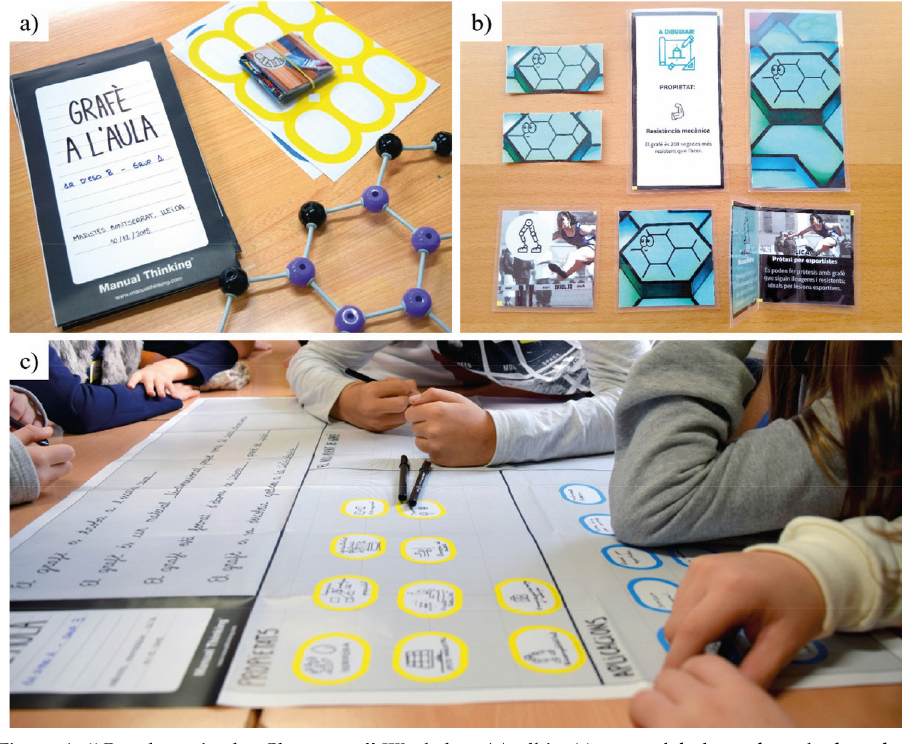
Figure 1. “Graphene in the Classroom” Workshop Toolkit: (a) maps, labels, and stacked cards; (b) “Memory” and “Pictionary” images, cards, and booklets; (c) spread out